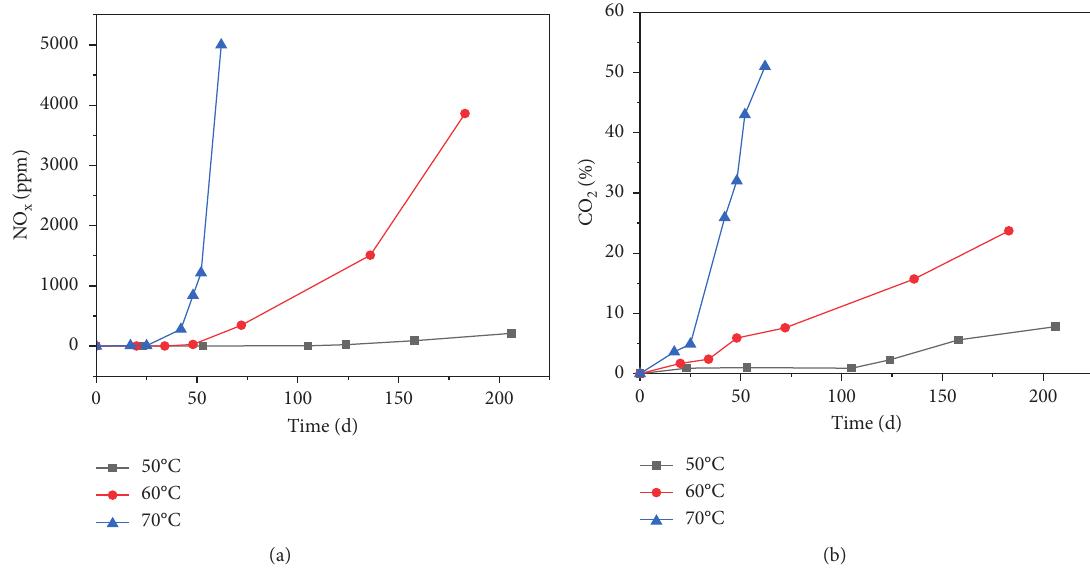
Figure 7: Variation of NO x and CO 2 release with storage time at different temperatures.